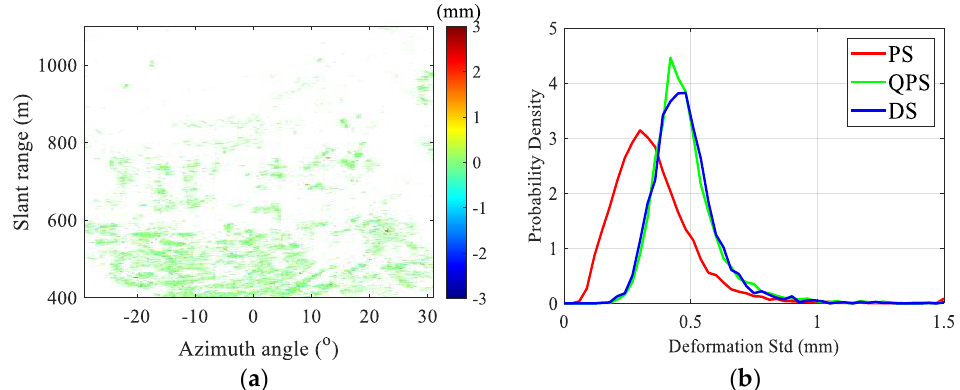
Figure 15. ( a ) Cumulative deformation map of the first 30 images; ( b ) probability density curves of the deformation std of three types of pixels: PS, QPS, and DS.